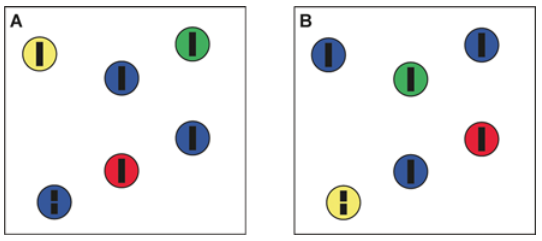
Fig 1. Search array examples. A: Array in positive cue type: “ target will be blue ” . B: Array in negative cue type: “ target will not be blue ” . Both arrays have the same spatial configuration of items and the target. The colors of the items were switched. The target is at the same location in the lower left corner. Search arrays are not to